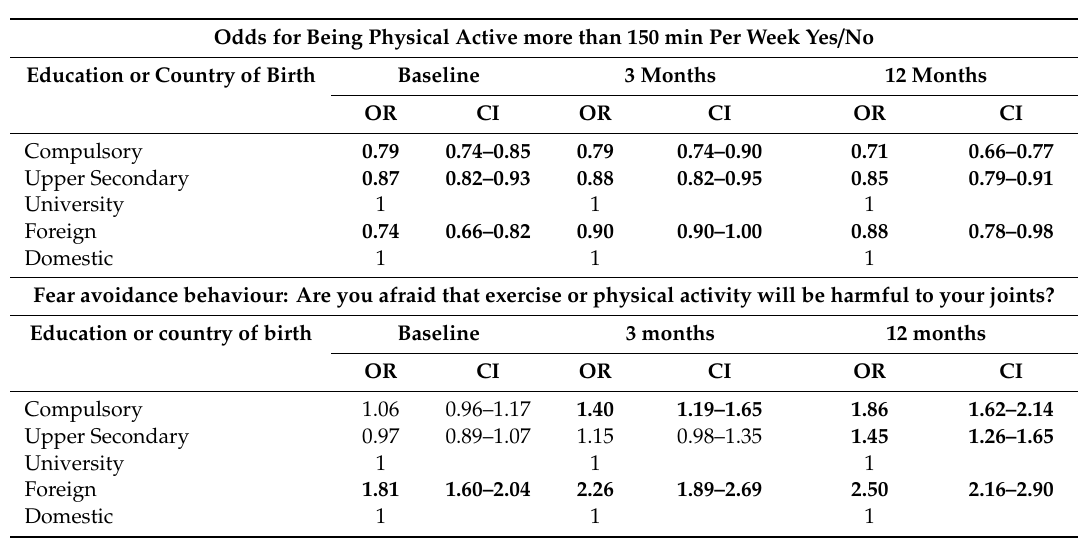
Table 5. Adjusted outcomes for variables related to health-related behaviours and adherence to the self-management program ( n =